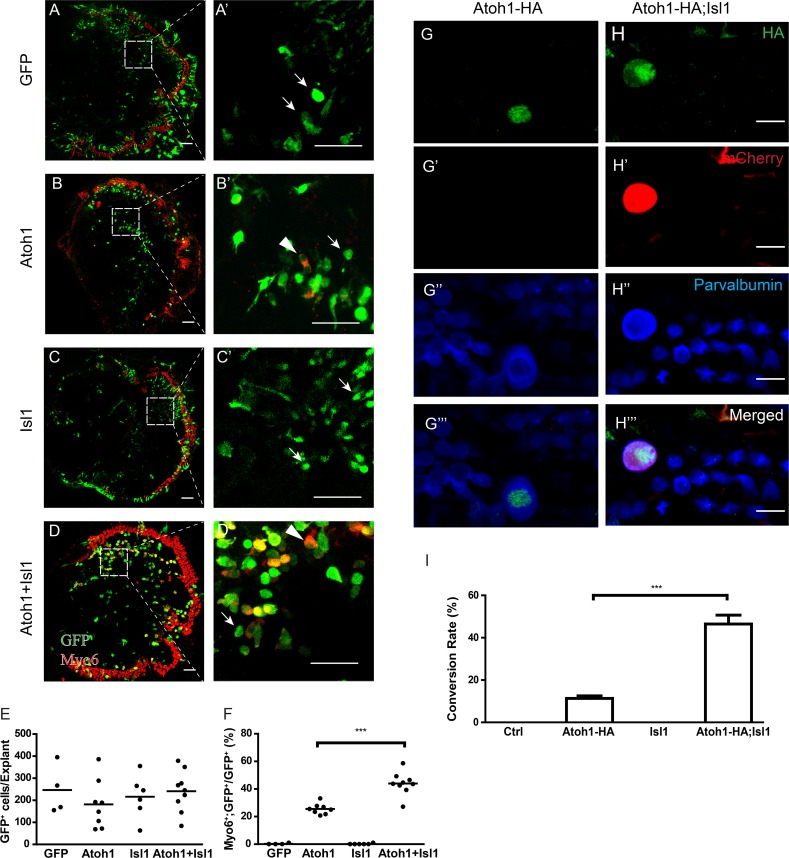
Isl1 synergistically enhances Atoh1-mediated SC-to-HC conversion ex vivo and in vivo.(A-D) Immunofluorescence staining of GFP (green) and Myo6 (red) in cultured cochlear explants 7 days after transfection. The explants were prepared from mice at P0 and transfected by electroporation with IRES-GFP alone (A and A’), Atoh1-IRES-GFP (Atoh1, B and B’), Isl1-IRES-GFP (Isl1, C and C’), or Atoh1-IRES-GFP and Isl1-IRES-GFP (Atoh1+Isl1, D and D’). GFP+ cells indicate transfected cells, and Myo6a is a HC marker. White arrows indicate nonconverted GFP-transfected GER cells, and white arrowheads indicate converted HCs that are positive for GFP and Myo6. The white boxes in panels A-D are enlarged in panels A’-D’, respectively. Scale bars represent 100 μm in A-D and 50 μm in A’-D’. (E, F) Scatter plots showing the conversion rates (E) as defined by the number of GFP+/Myo6+ double-positive cells divided by the number of GFP+ cells and the transfection rates (F) as defined by the number of GFP+ GER cells of corresponding explants. Each dot represents a sample; lines indicate mean values. ***P < 0.001 by Student’s t-test. (G-H) Immunofluorescence staining of HA (green), mCherry (red), and parvalbumin (blue) in the HC layer of cochlear wholemounts of Fgfr3-iCreER; Atoh1-HA (Atoh1-HA, G-G”‘) and Fgfr3-iCreER; Atoh1-HA; Isl1-IRES-mCherry (Atoh1-HA; Isl1, H-H”‘) mice. The mice that received tamoxifen injection at P12 and P13 were analyzed at P33. Scale bars represent 10 μm. (I) Quantification of conversion rate (see Methods for the calculation) in Fgfr3-iCreER; tdTomato (Ctrl), Atoh1-HA, Fgfr3-iCreER; Isl1-IRES-mCherry (Isl1), and Atoh1-HA; Isl1 mice. Data are presented as average ± SEM. ***P < 0.001 by Student’s t-test.